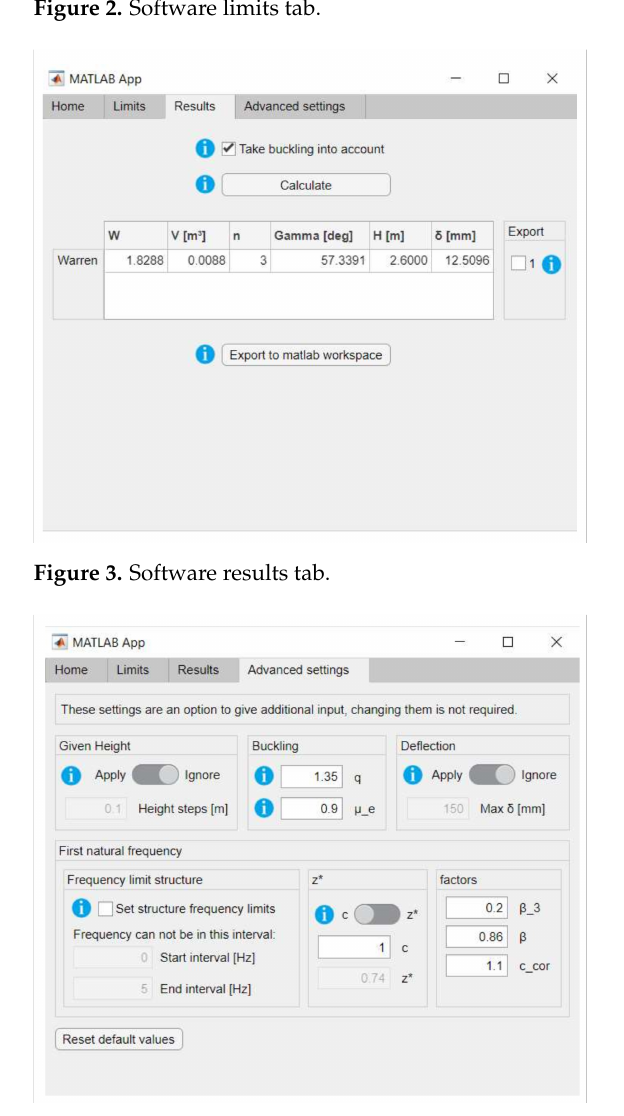
Figure 4. Software advanced settings